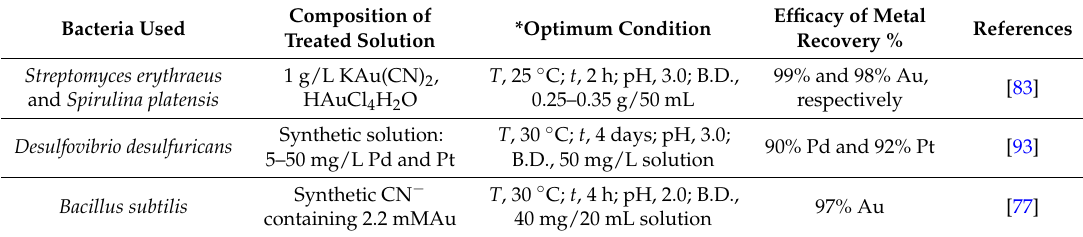
Table 5. A summary of the biosorption studies of precious metals using dead bacterial biomass ( T = temperature, t = contact time, B.D. = biosorbent